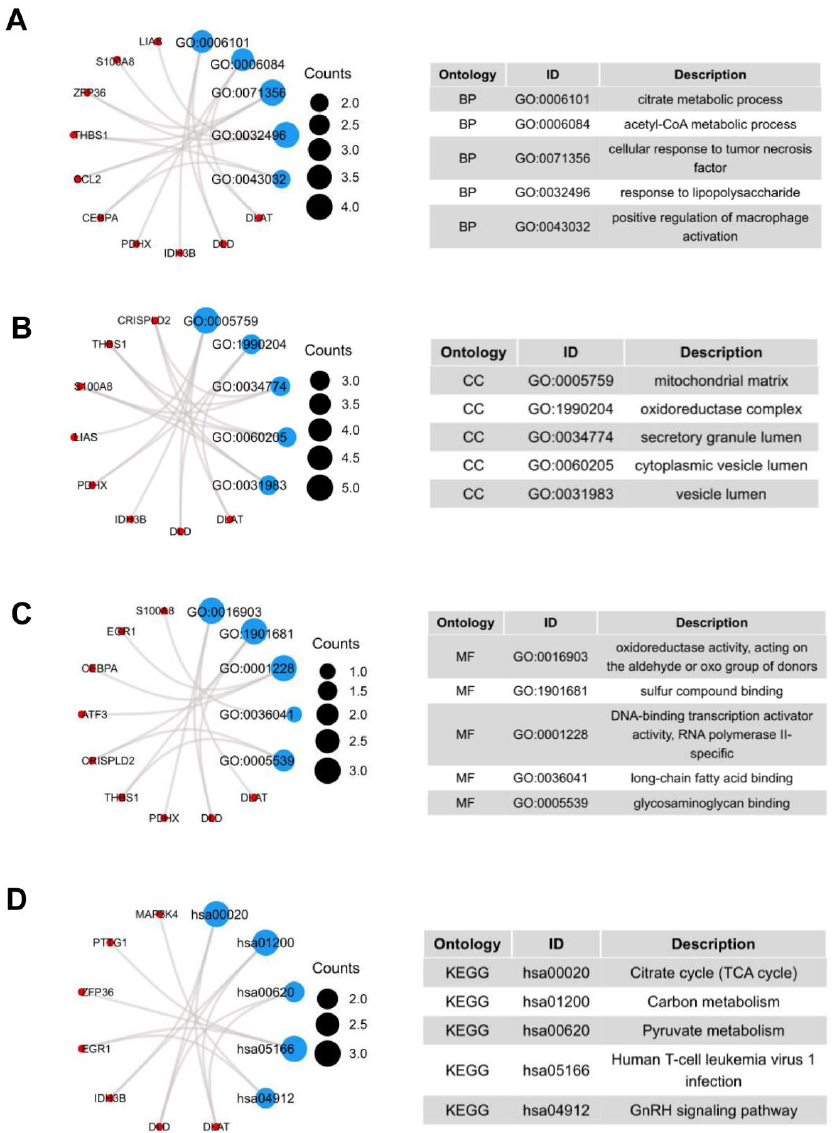
Figure 2. GO terms and KEGG pathway of the common 19 DEGs. ( A ) Biological Processes, ( B ) Cellular Component, ( C ) Molecular Function, ( D ) KEGG Human Pathway.